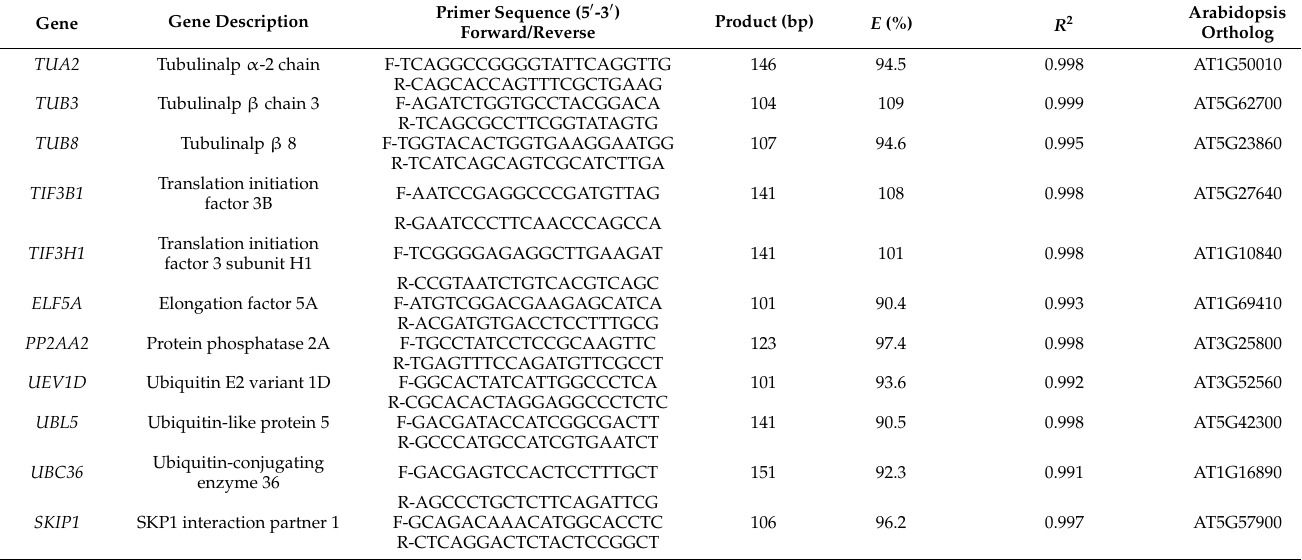
Table 1. Primer sequences of eleven potential reference genes; RT-qPCR effectiveness ( E ) in Saussurea laniceps